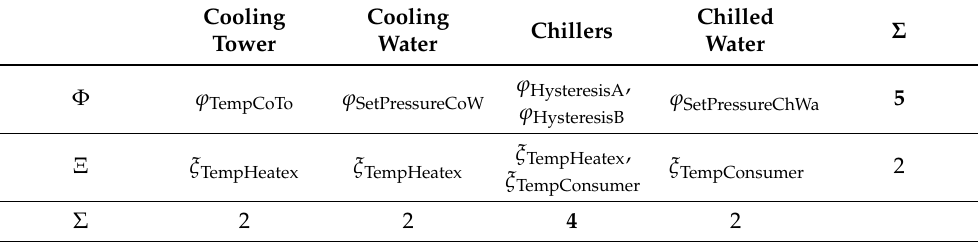
Table 2. Overview of variables for each subsystem: While optimizing the entire system evokes a problem with five free influence variables, decomposing the entire system reduces to a maximum number of four dimensions to be considered from free variables Φ and arbitrary but fixed variables Ξ